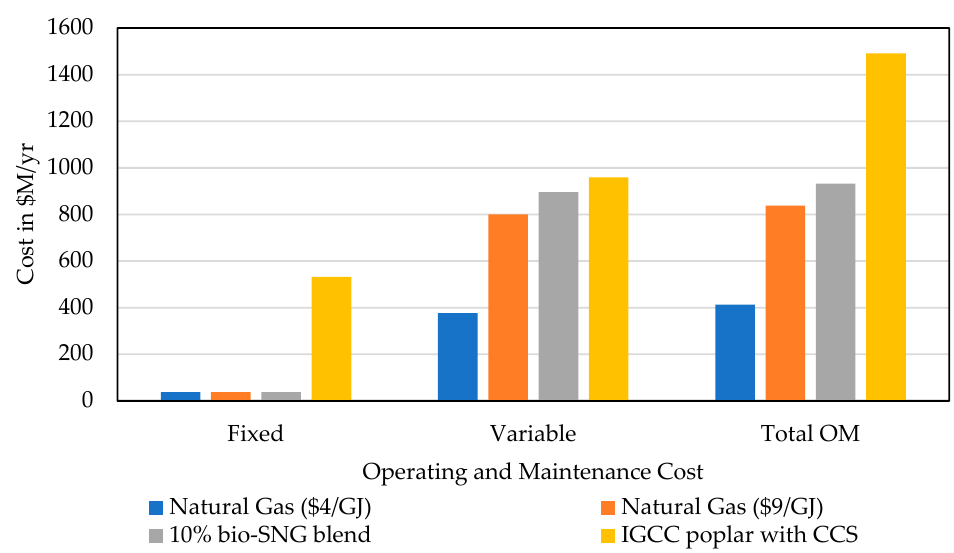
Figure 10. Predicted LCOE for NGCC power plants co-fired with upgraded syngas produced from poplar.